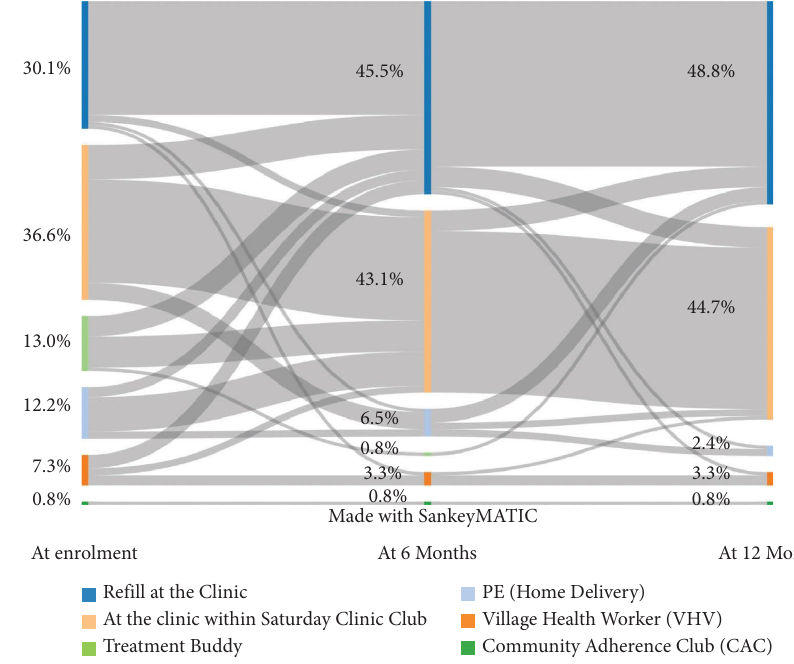
Figure 1: Sankey diagram for longitudinal visualization of ART refll site preferences. Abbreviations: CAC (community adherence club), PE (peer educator), and VHW (village health worker).